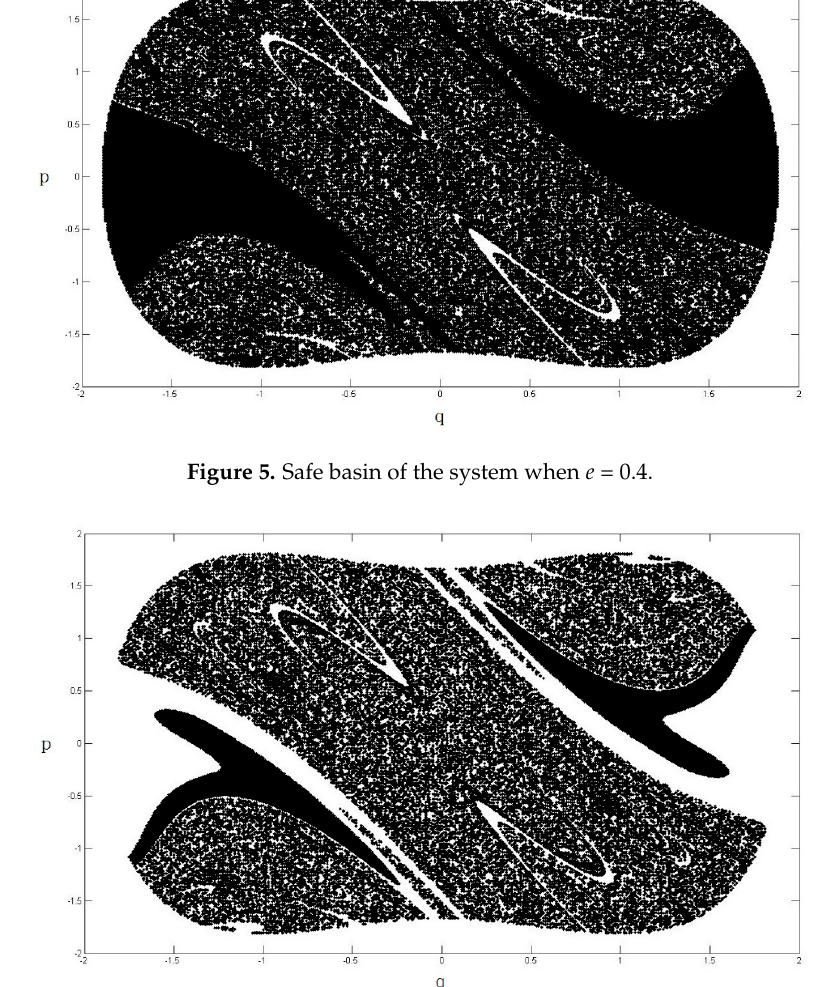
Figure 7. Safe basin of the system when e = 0.8. From Figures 4–7, it is clear that the area of safe basin decreases significantly with increasing parameter e .